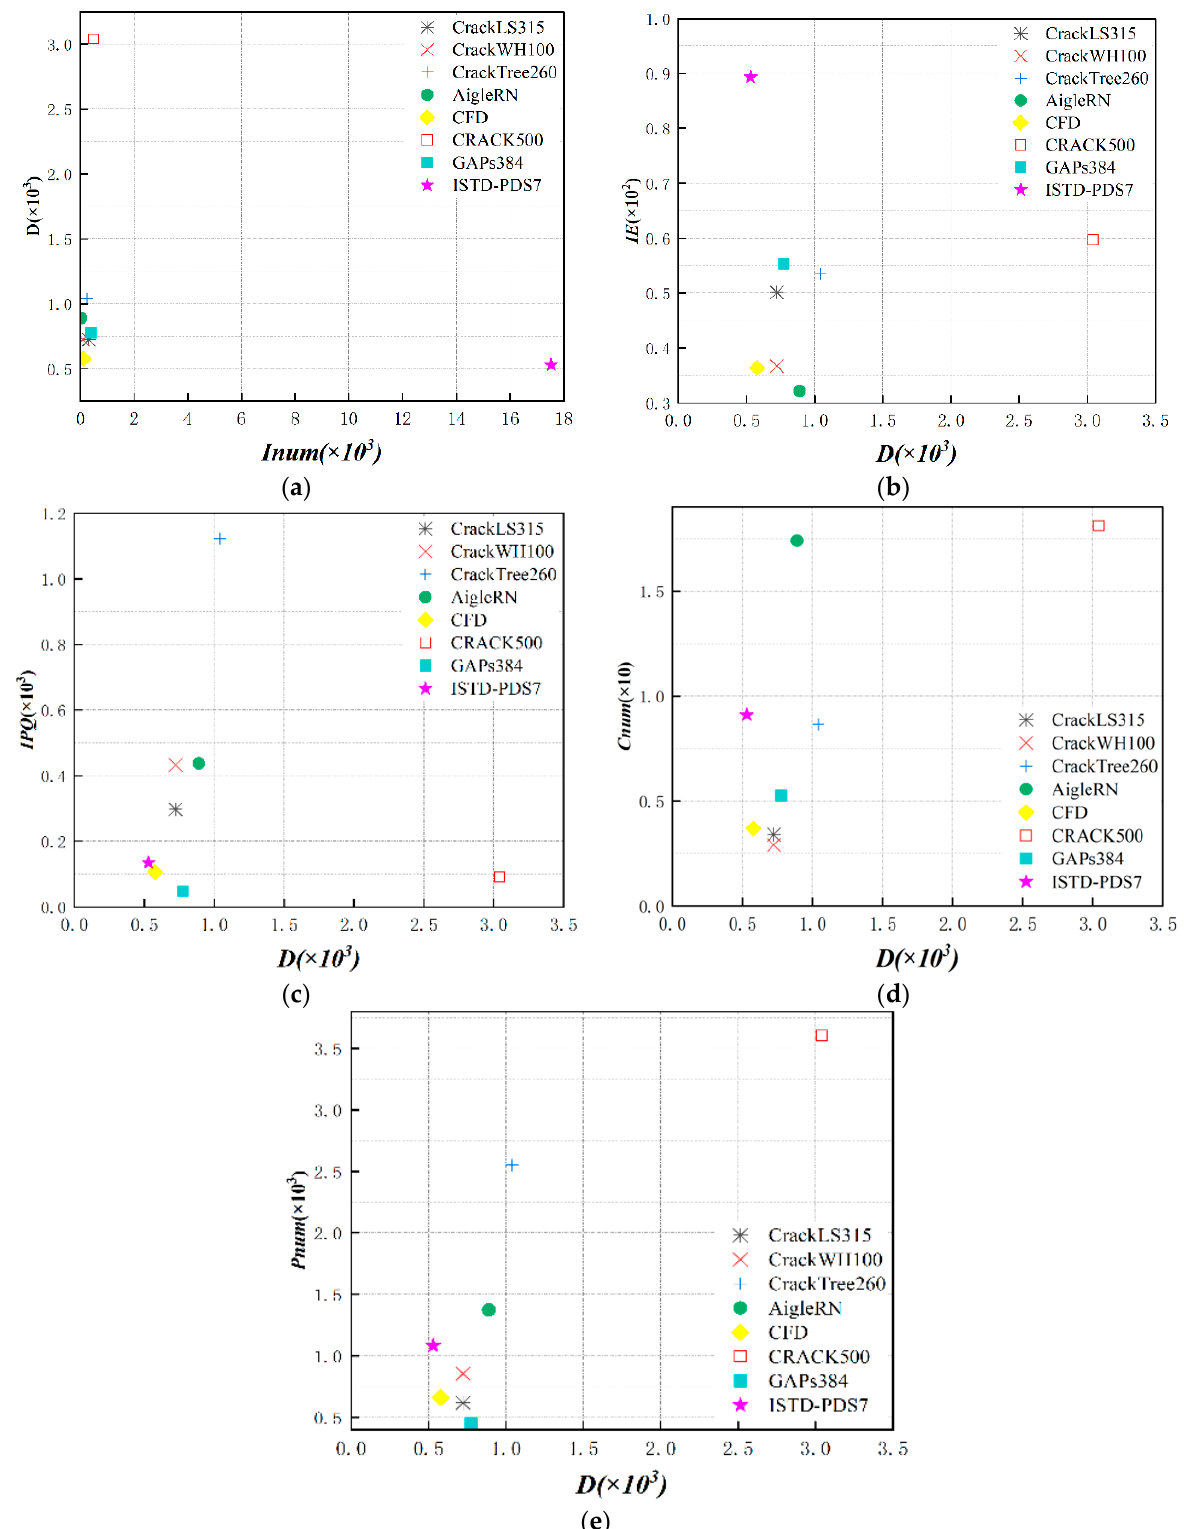
Figure 7. Correlations between the different complexity metrics. These four complexity measurements are complementary and can provide a comprehensive analysis of the complexity of the original imagery and annotated objects ( a – e ).